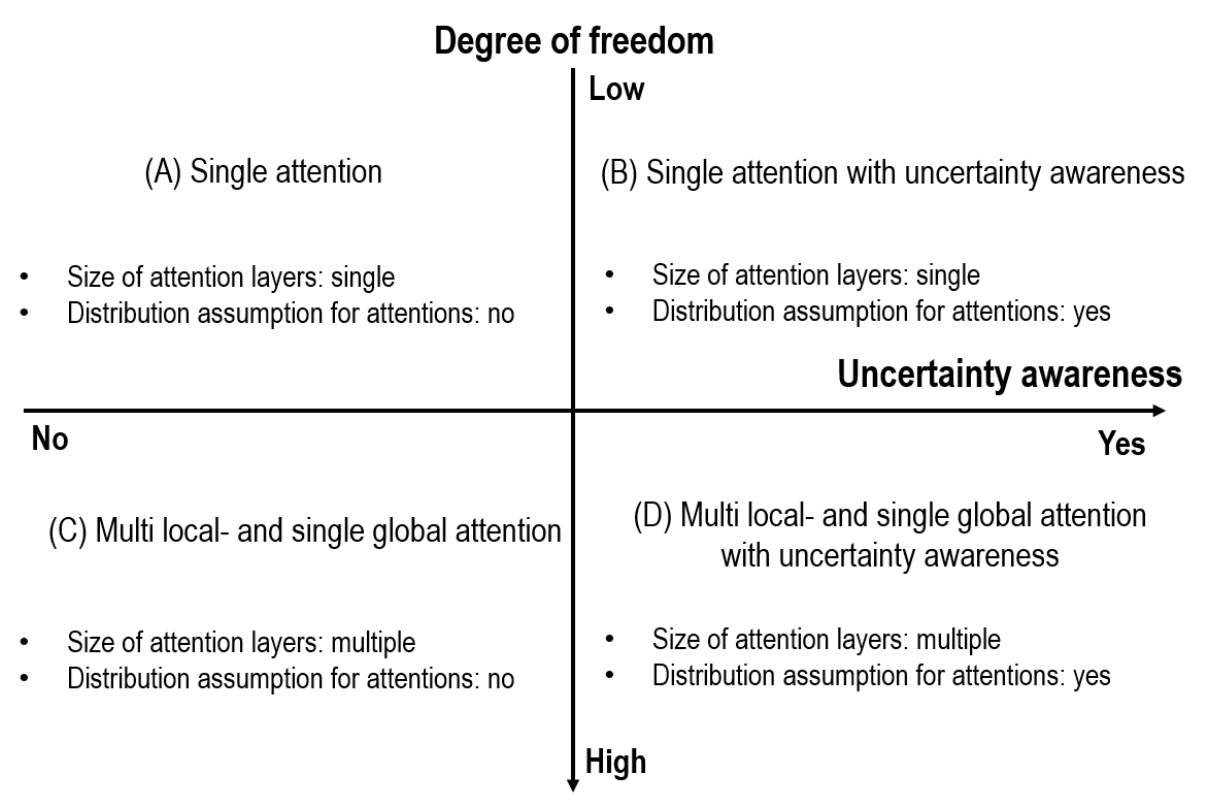
Figure 2. Framework for empirical